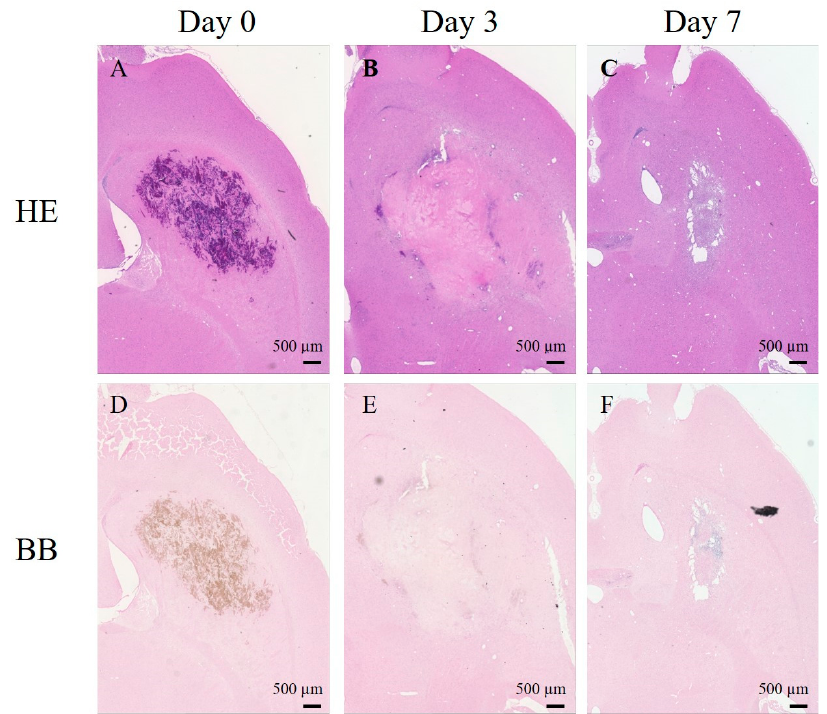
Figure 4. Histopathological changes in the intracranial hemorrhage area at various stages. ( A – C ) Hematoxylin and eosin (HE) staining. ( D – F ) Berlin blue (BB) staining.